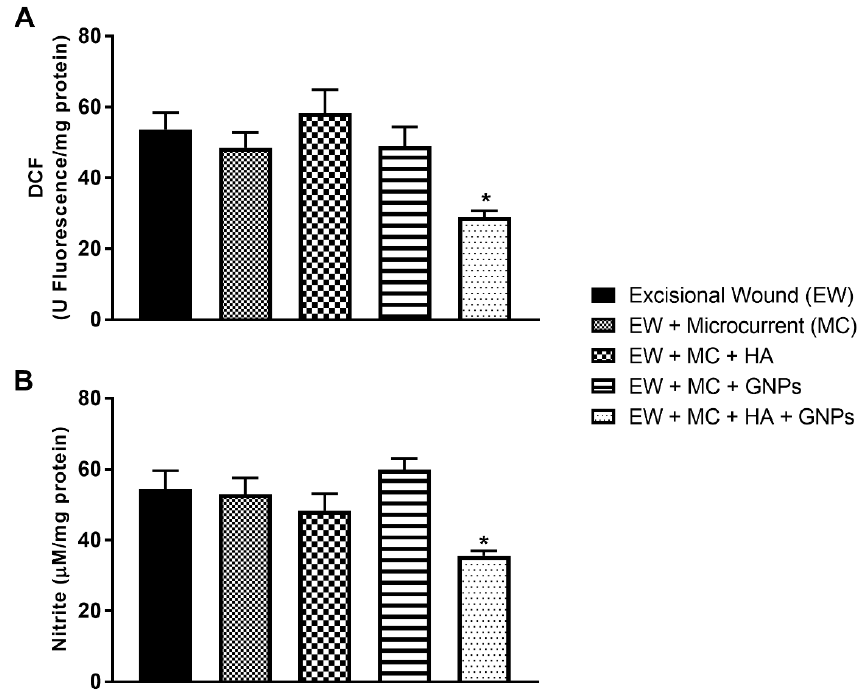
Figure 7. Effects of treatment with MC, GNPs, and hyaluronic acid on the levels of oxidants: ( A ) DCF; ( B ) nitrate. The data are presented in mean ± EPM, in which * p < 0.05 vs. excisional wound group (EW) (one- way ANOVA followed by Tukey’s post hoc test).